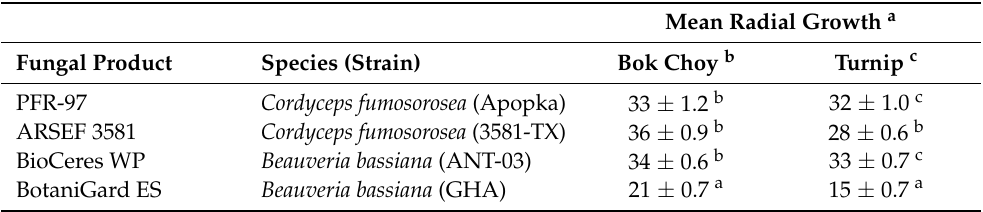
Table 1. Comparison of the mean ( ± SE) fungal radial growth (mm) at 15 days of four ento- mopathogenic fungal products on PDA with either bok choy or turnip leaf